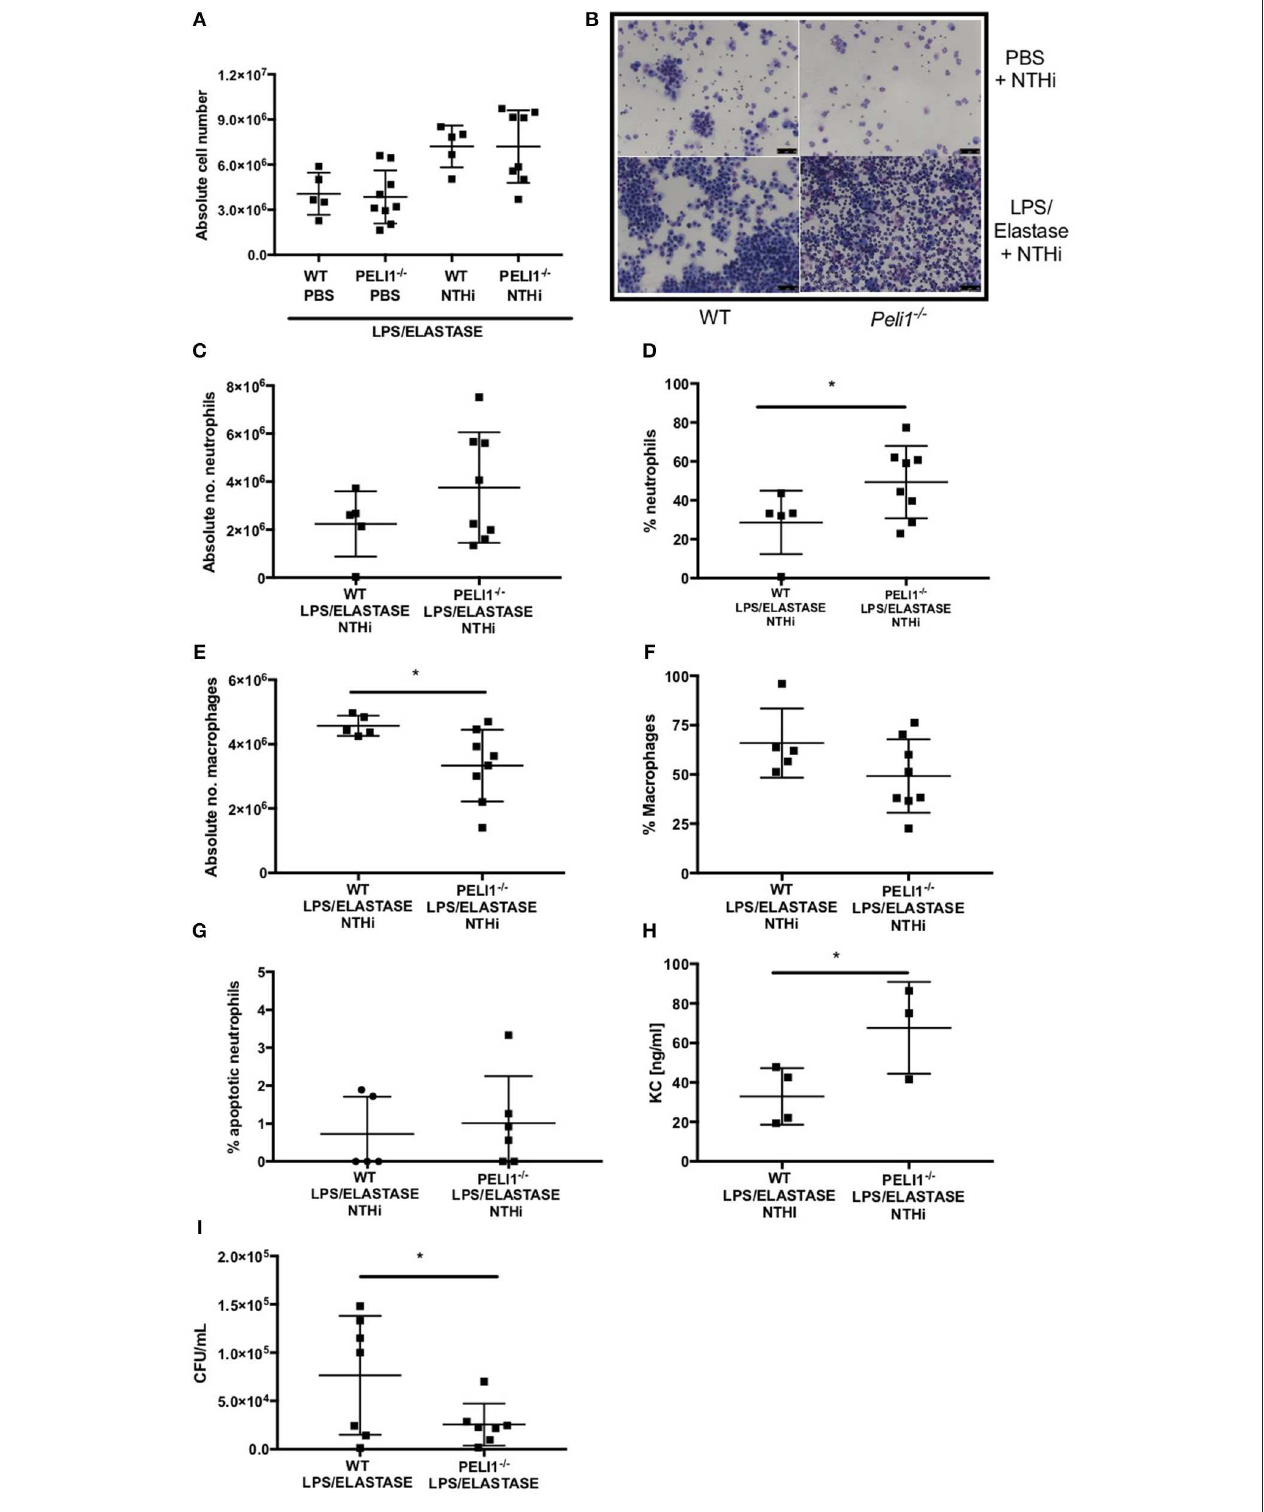
FIGURE 4 | Peli1 − / − COPD mice recruit more neutrophils following NTHi infection and clear NTHi more effectively compared to WT. Peli1 − / − transgenic mice and WT littermates were given i.n. LPS [7 µ g] and 1.2 units porcine neutrophil elastase every 7 days for 4 weeks. On day 28, mice were infected with 1 × 10 7 CFU NTHi.